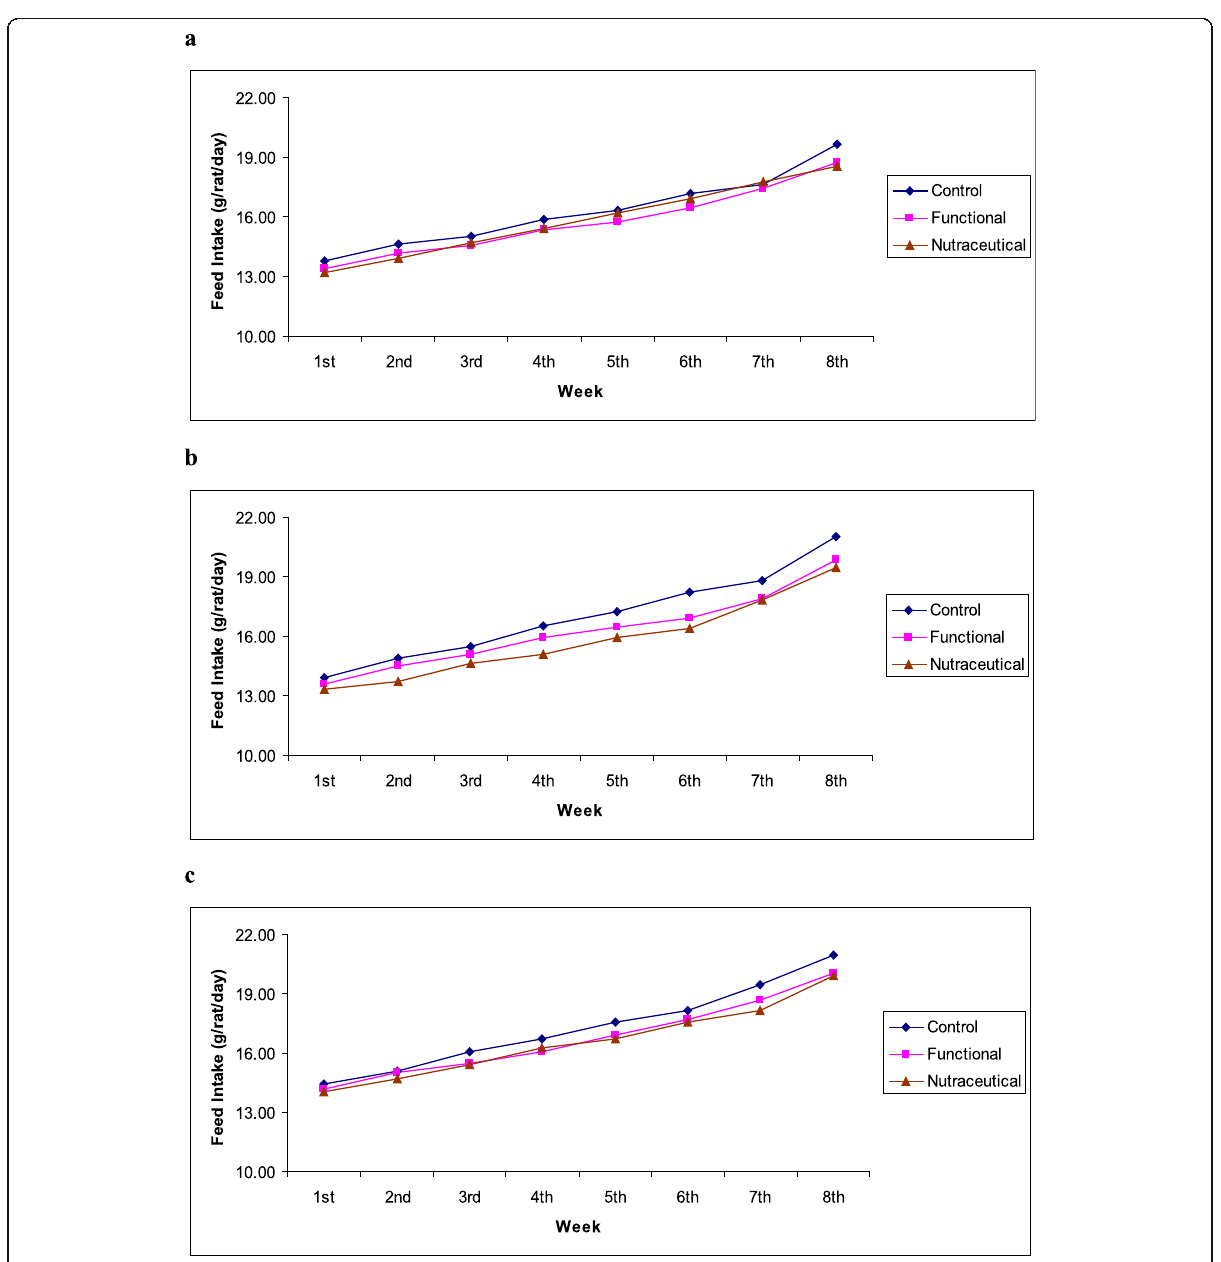
Fig. 1 Feed intake in different studies (g/rat/day) ( a ) Study I: Normal rats; ( b ) Study II: Hyperglycemic rats; and ( c ) Study III: Hypercholesterolemic